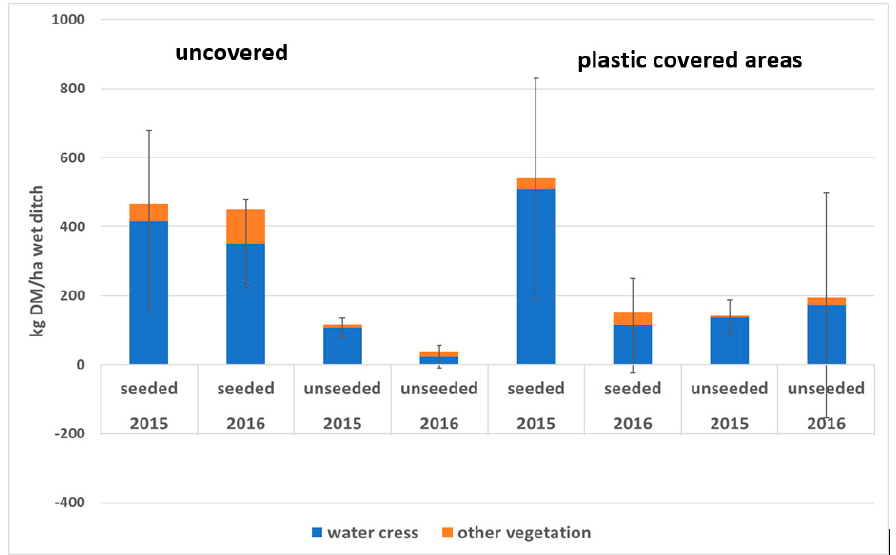
Figure 5. Average dry matter content and SD of above-ground growth in the seeded and unseeded ditches, for June 2015 and May 2016, uncovered and plastic covered areas, per unit wetted area of ditch. Width of the wet ditches is assumed to be 0.5 m. The SD of watercress DM is also shown ( n = 5).